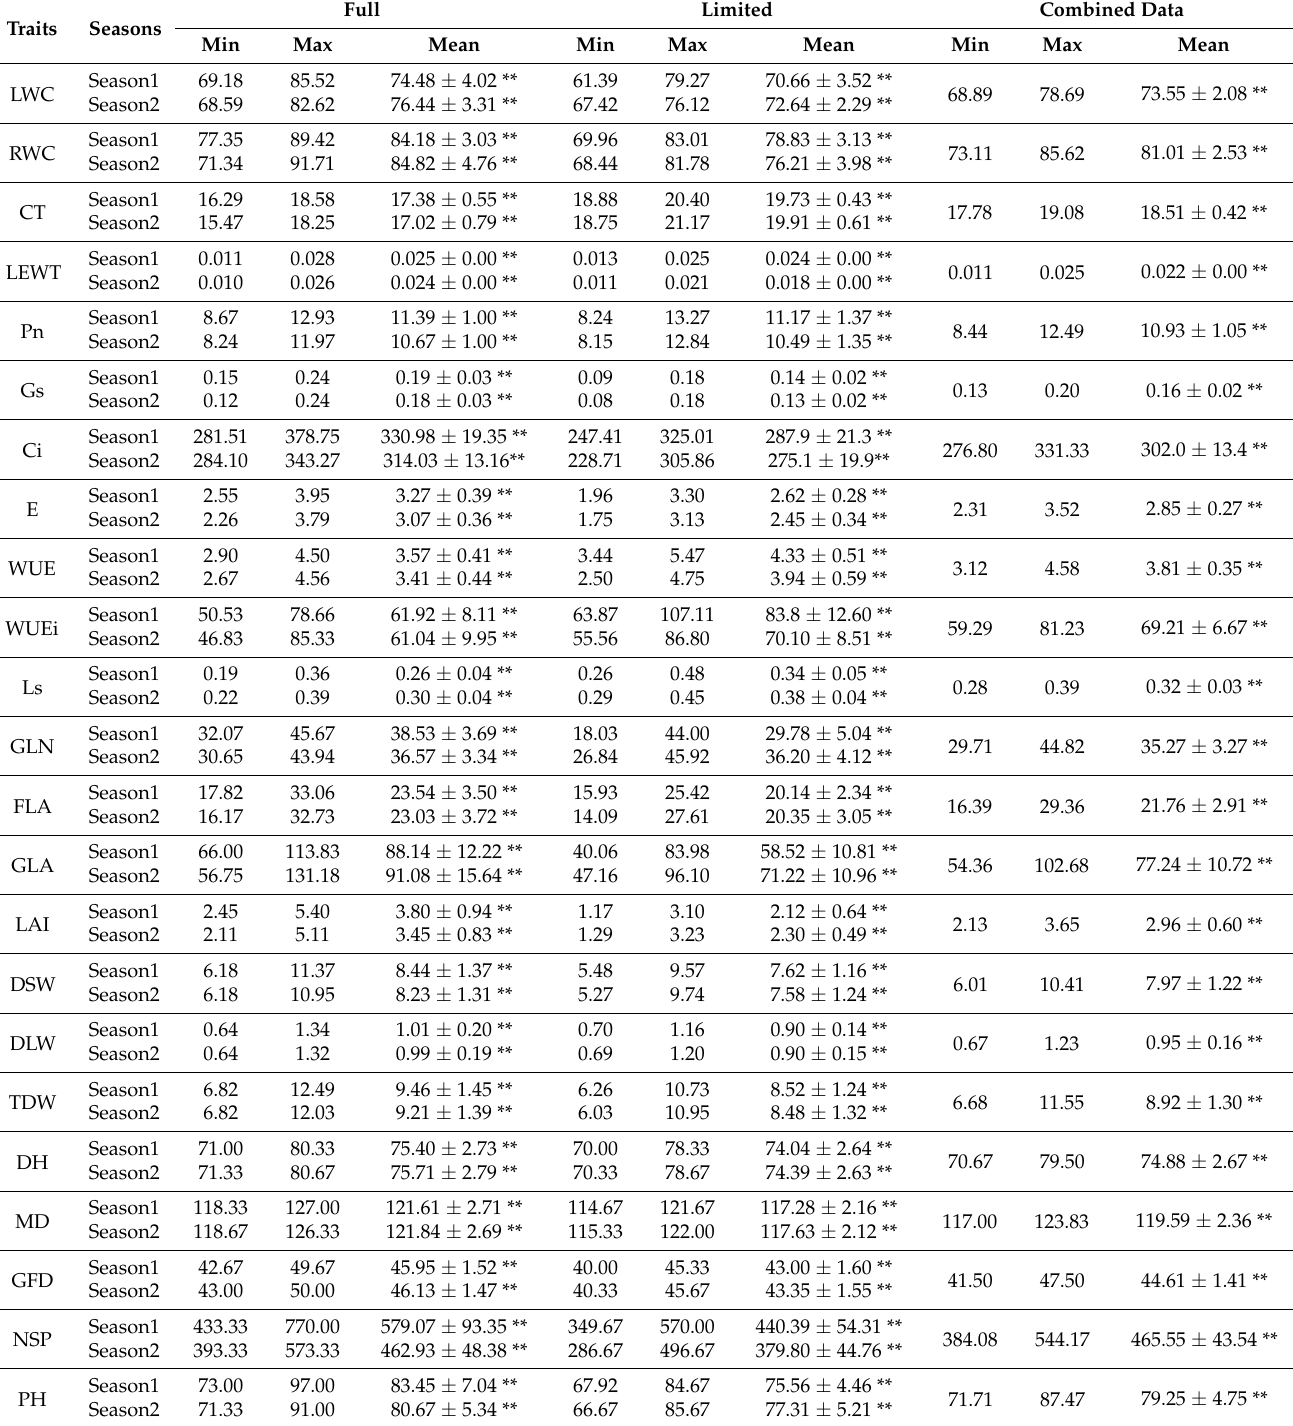
Table 2. Means ± standard deviation, ranges of the 25 genotypes of two seasons and their combined for 28 traits.